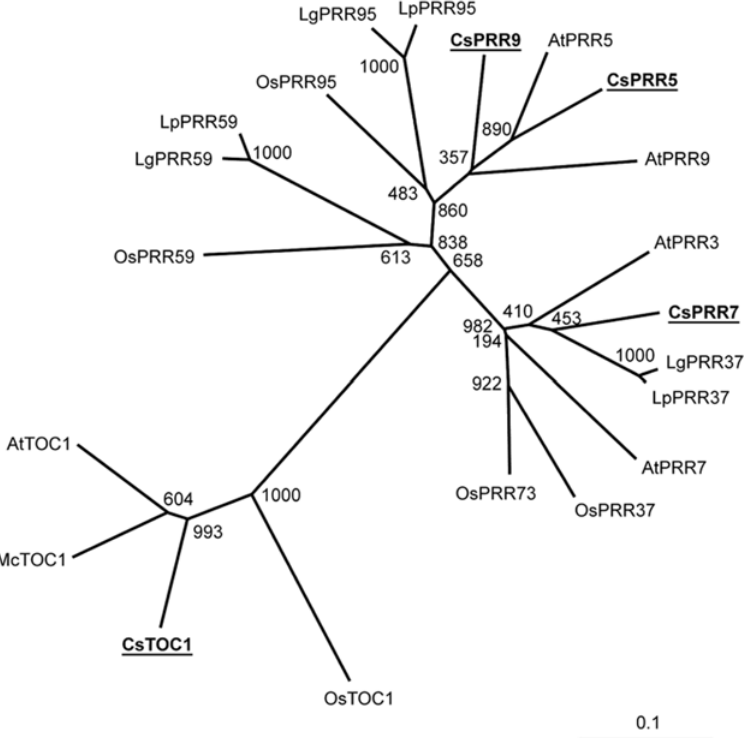
Figure 1. Phylogram of PRR proteins. A non-rooted neighbor-joining phylogenetic tree of PRR proteins was constructed using amino acid sequences of the pseudo-receiver domain (55). Species identifiers are: At, Arabidopsis thaliana ; Cs, Castanea sativa ; Lg, Lemna gibba ; Lp, Lemna paucicostata ; Mc, Mesembryanthemum crystallinum ; Os, Oryza sativa . The following are the accession numbers for the proteins: AtTOC1 (AF272039); AtPRR3 (BAB13744); AtPRR5 (BAB13743); AtPRR7 (BAB13742); AtPRR9 (BAB13741); CsTOC1 (AY611028); CsPRR5 (ABV53464); CsPRR7 (ABV53463); CsPRR9 (ABV53465); LgPRR37 (BAE72700); LgPRR59 (BAE72701); LgPRR95 (BAE72702); LpPRR37 (BAE72697); LpPRR59 (BAE72698); LpPRR95 (BAE72699); McTOC1 (AAQ73525); OsTOC1 (BAD38854); OsPRR37 (BAD38855); OsPRR59 (AK120059) (KOME database); OsPRR73 (BAD38856); OsPRR95 (BAD38857). Numbers at each branch point indicate the bootstrap replicates (out of 1000) giving rise to the topology. doi:10.1371/journal.pone.0003567.g001 PLoS ONE |